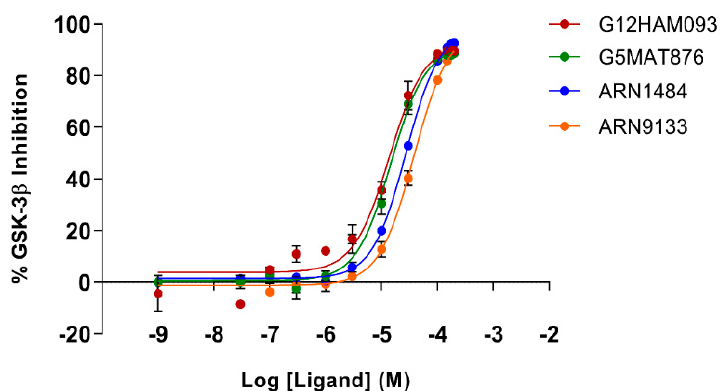
Figure 14. Dose-response curves for GSK-3 β inhibition by ARN1484 (blue), ARN9133 (orange), G5 Figure 14. Dose − response curves for GSK-3 β inhibition by ARN1484 (blue), ARN9133 (orange), G5 Figure 14. Dose − response curves for GSK-3 β inhibition by ARN1484 (blue), ARN9133 (orange), G5 (green) and G12 (red). Error bars denote SD. (green) and G12 (red). Error bars denote SD. (green) and G12 (red). Error bars denote SD. Figure 14. Dose − response curves for GSK-3 β inhibition by ARN1484 (blue), ARN9133 (orange), G5 (green) and G12 (red). Error bars denote SD.